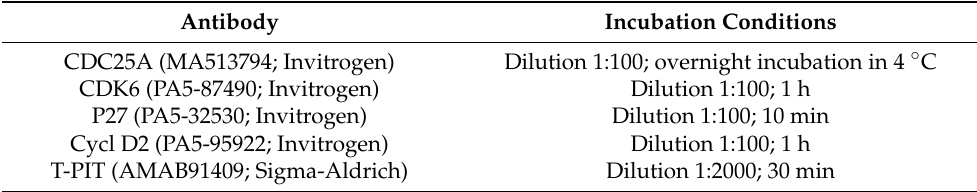
Table 2. The list of antibodies used for immunohistochemistry and incubation conditions.